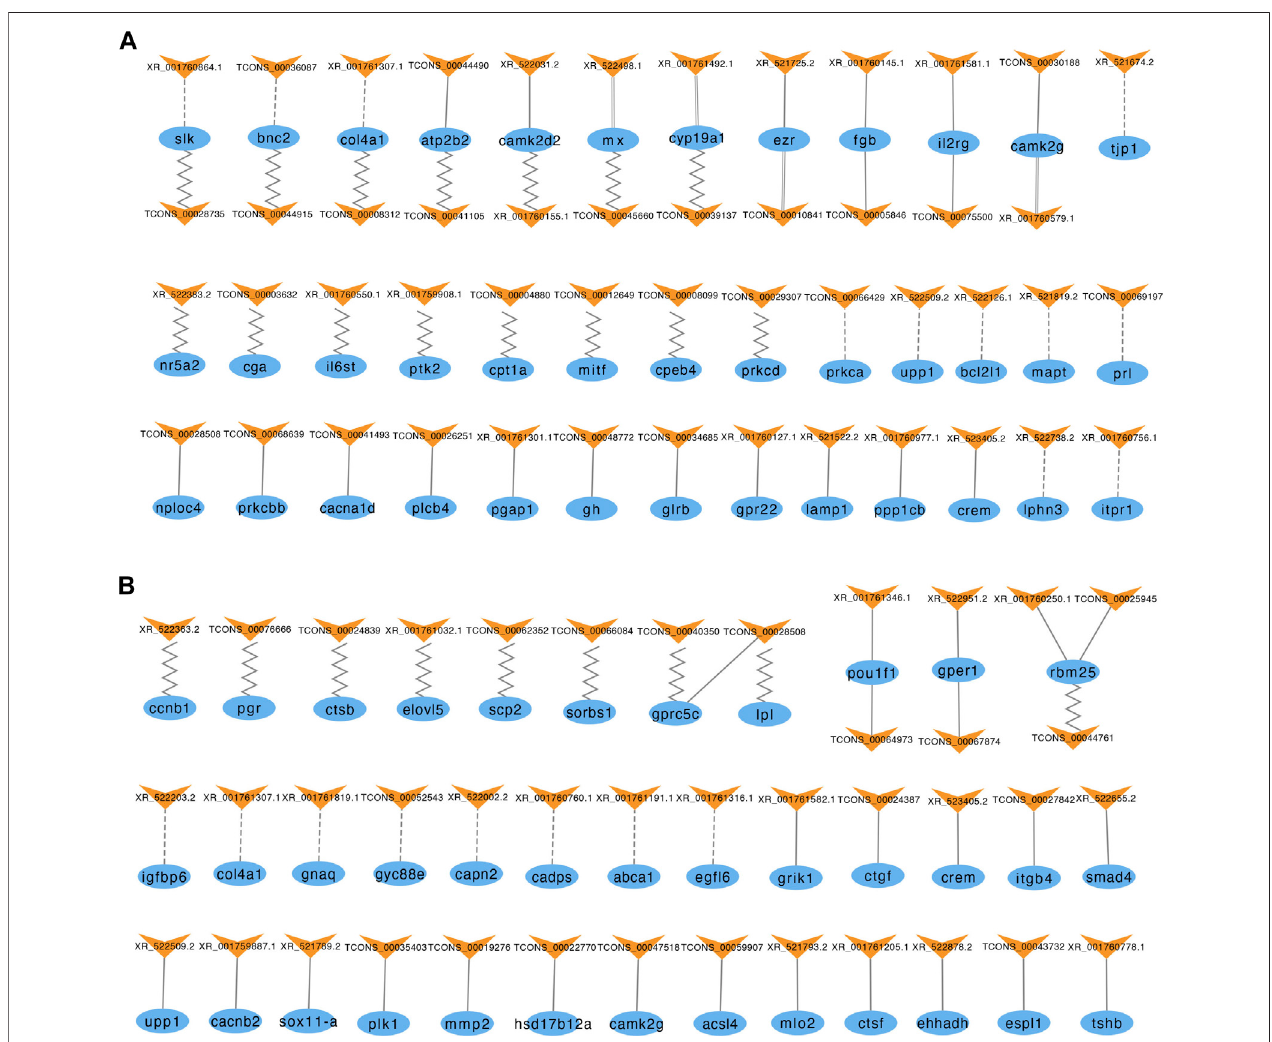
FIGURE 5 | LncRNAs and their antisense , cis , and trans target genes in the brain (A) and pituitary (B) . The blue ellipses represent mRNAs, and the yellow “ V ” symbols represent lncRNAs. The dashed, solid, parallel and jagged lines indicate interactions between DE lncRNAs and their antisense , cis , and trans positive and negative target